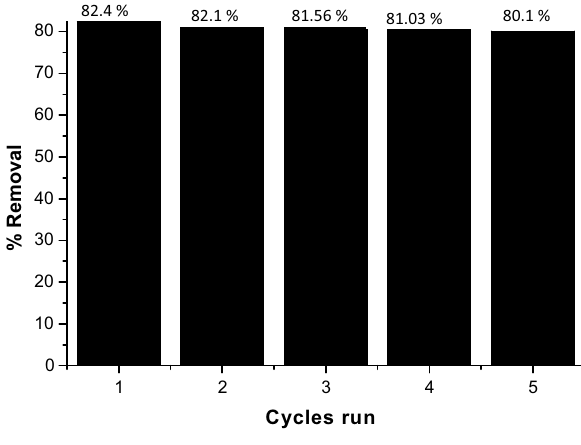
Fig. 8 Reusability test of CP-1 for removal of